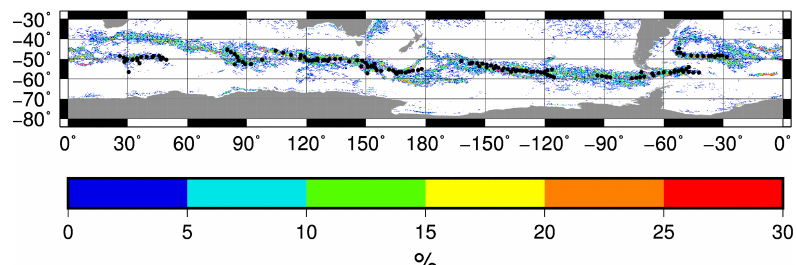
Figure 7. Mean positions of fronts estimated from CKE (black dots) along with the percent occurrence of a jet between 1993 and 2014 computed by Chapman (2017a). Data were downloaded from https://doi.org/10.5061/dryad.q9k8r (Chapman, 2017b). The percent occurrence of the jet was computed by calculating the number of times a jet occurred in the daily files, dividing by the total number of days between January 1993 and December 2014 and multiplying by 100.